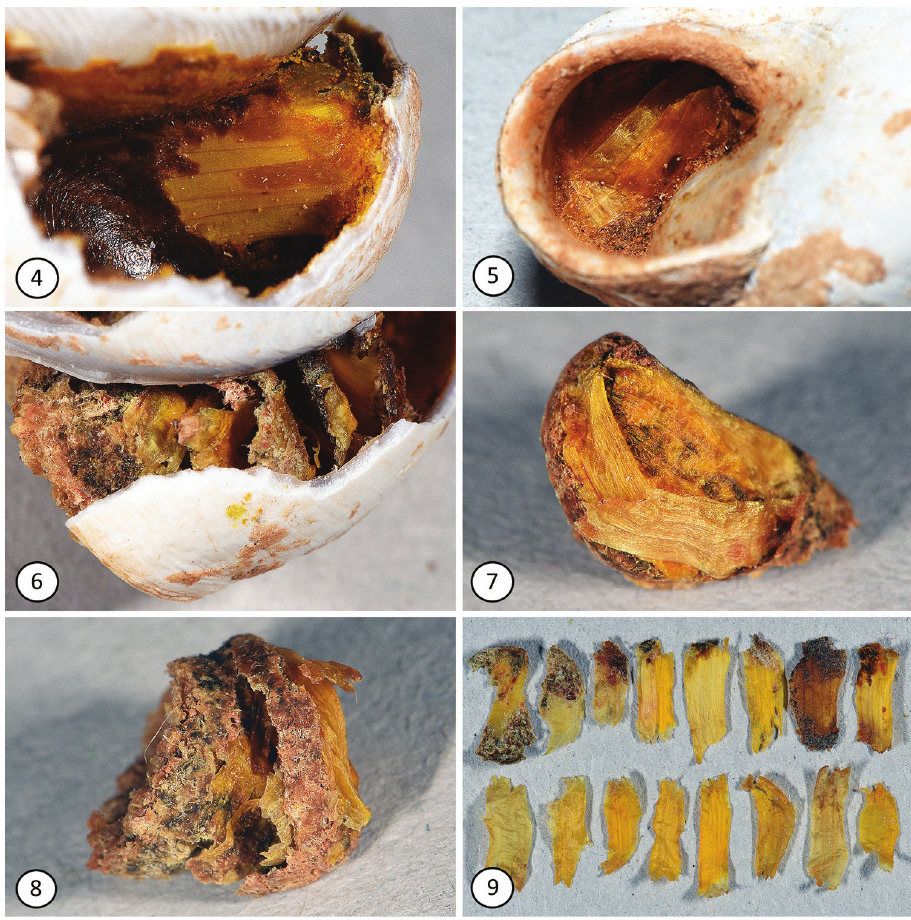
Figures 4–9. Wainia sexsignata . 4 Brood cell partition built from yellow petal pieces of Asteroideae, which are partly covered with dark brown remnants of the larval cocoon; note the portion of leaf pulp at the right upper side of the partition used to glue the petal pieces to the inner shell surface 5 Partition of the nest plug 6 Nest plug consisting of a series of four partitions constructed from yellow Asteroideae petal pieces immediately followed by the nest closure at the shell opening, which consists of leaf pulp; the partition at the extreme right is the outermost brood cell partition 7 Yellow petal pieces adhering to the rear side of the nest closure 8 Anterior part of the nest plug with an additional wall of leaf pulp built in front of the second outermost plug partition 9 Asteroideae petal pieces used to construct cell and plug partitions; petals in the upper row with traces of leaf pulp, which glued them to the inner shell